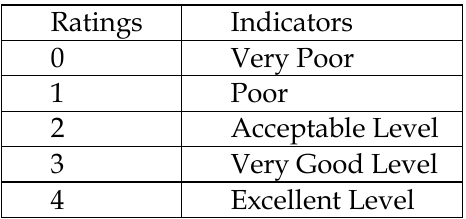
Table 1:Key Performance Indicators (KPI)